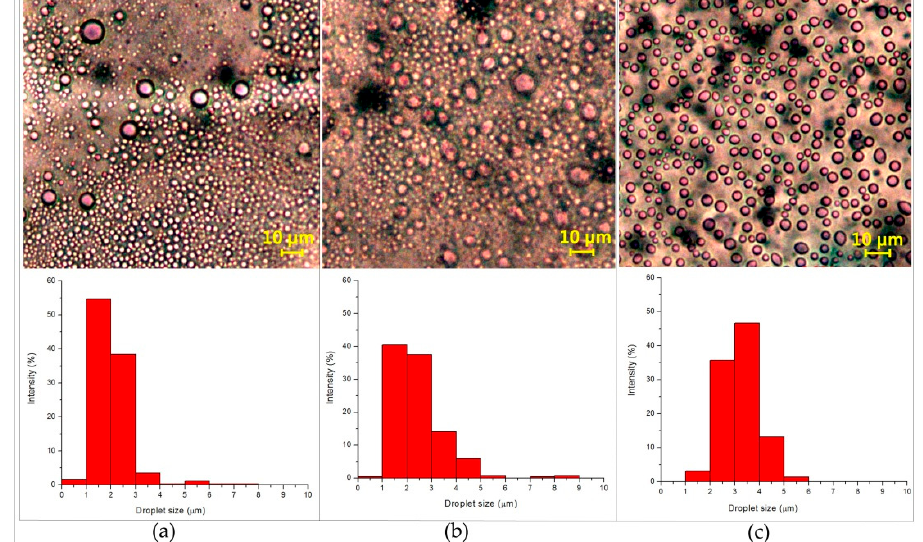
Figure 4. Optical micrographs (top) and droplet size distributions (bottom) of emulsions prepared at different oil to water ratios: ( a ) 1:3, ( b ) 1:2, and ( c ) 1:1. The concentration of CNCs was 2 wt % for all emulsions.